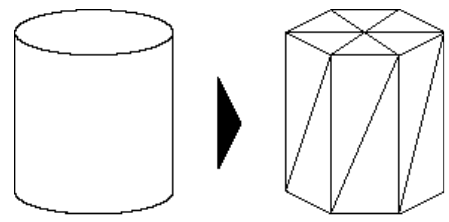
Figure 1. Triangulated surface of a cylinder based on